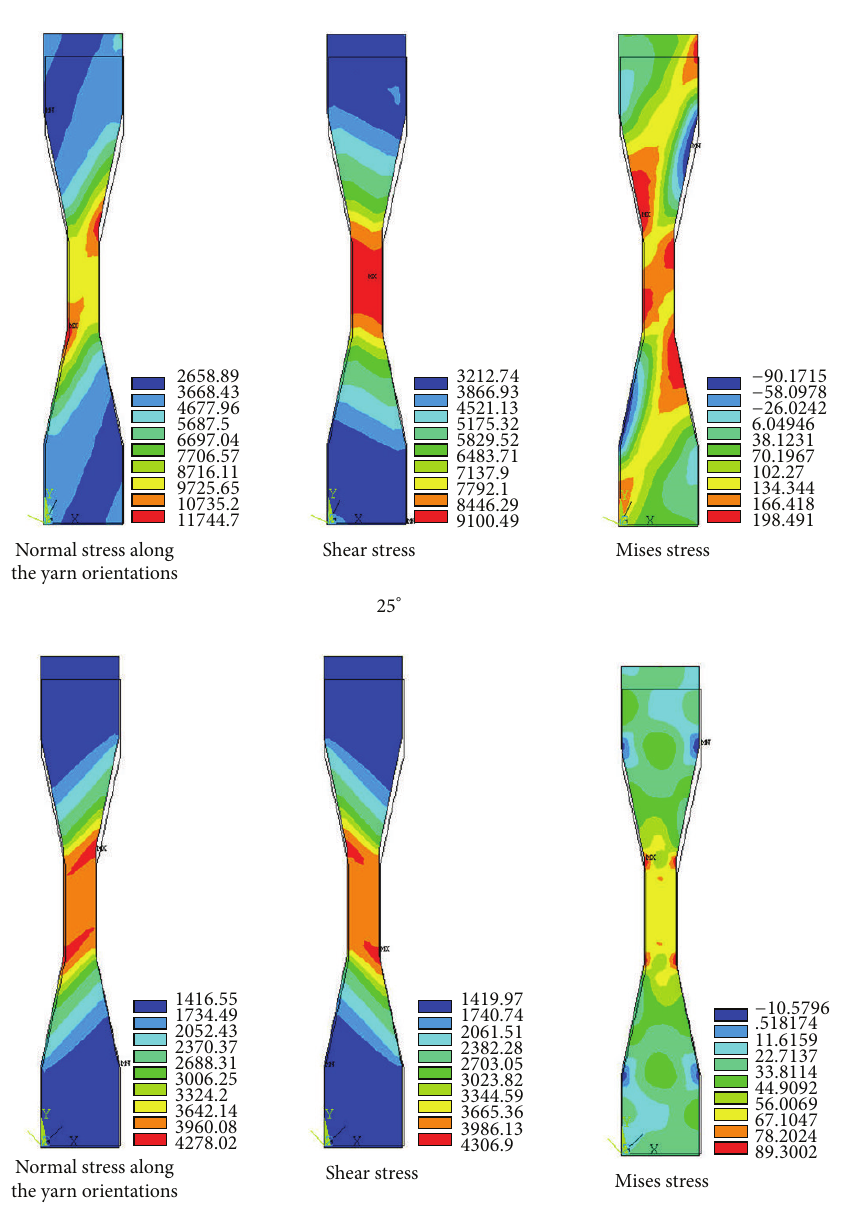
Figure 5: Finite element analysis of off-axial tensile test (Precontraint 702